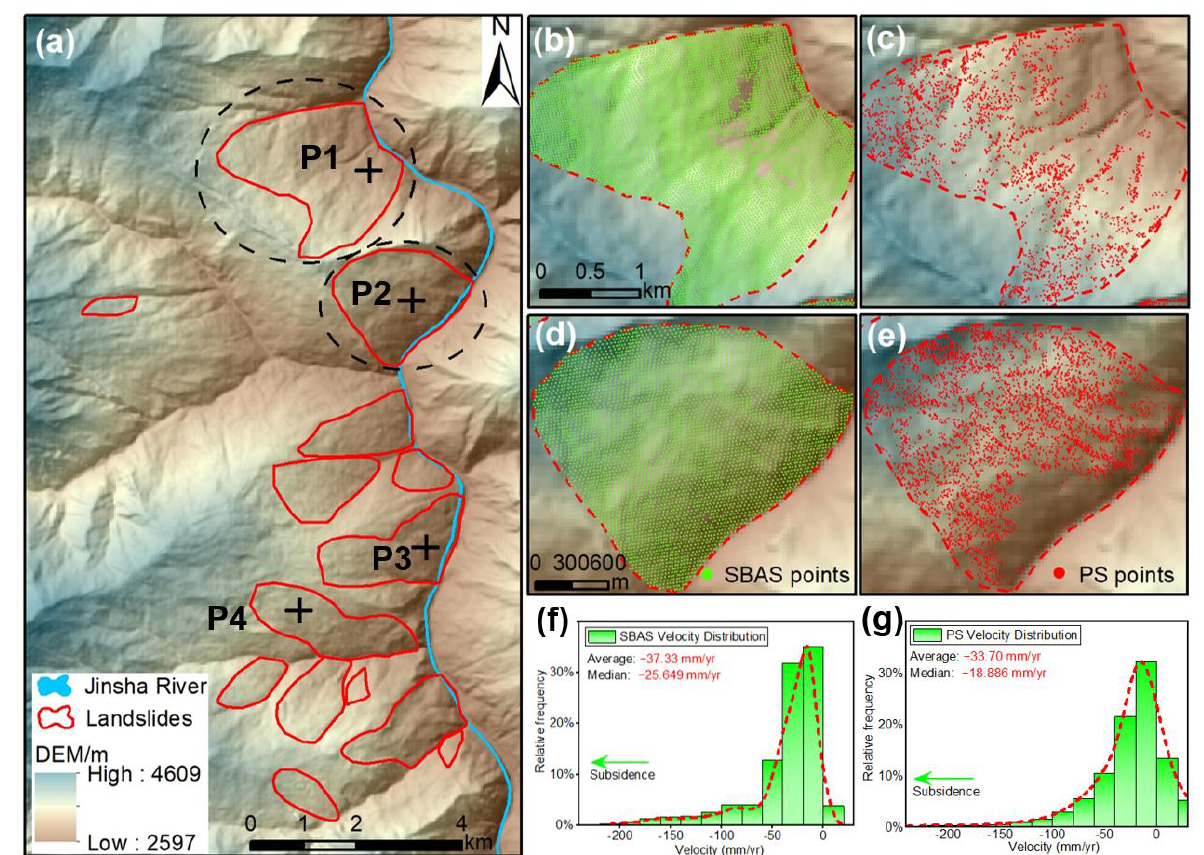
Figure 13. Time-series points distribution and histogram of deformation rate of SBAS and PS-InSAR: ( a ) spatial position of landslides; ( b – e ) time-series points of two large landslides; ( f , g ) histogram of deformation rate, the normal density function is fit by red dotted lines.